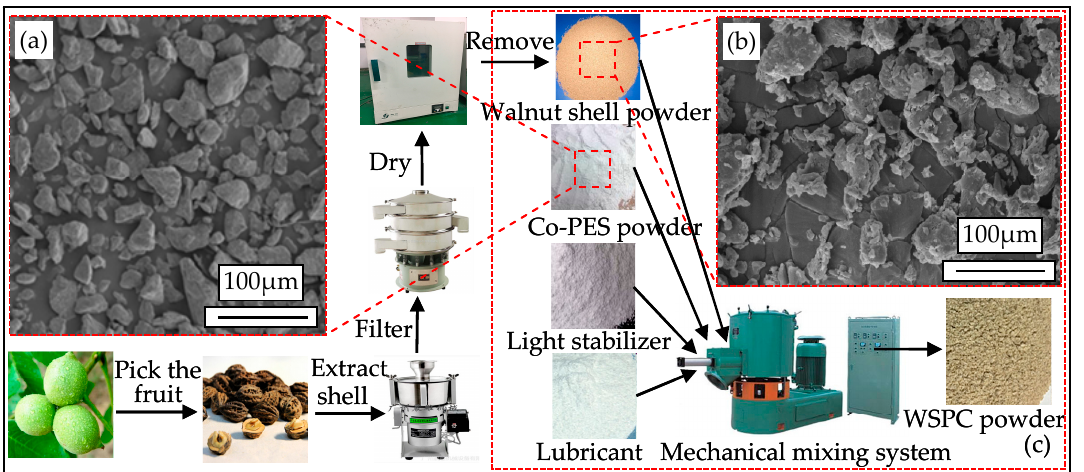
Figure 1. Walnut shell composites (WSPC) power preparation process: ( a ) copolyester hot melt adhesive (Co-PES) powder particles morphology; ( b ) walnut shell powder particles morphology; and ( c ) WSPC powder mechanical mixing process.